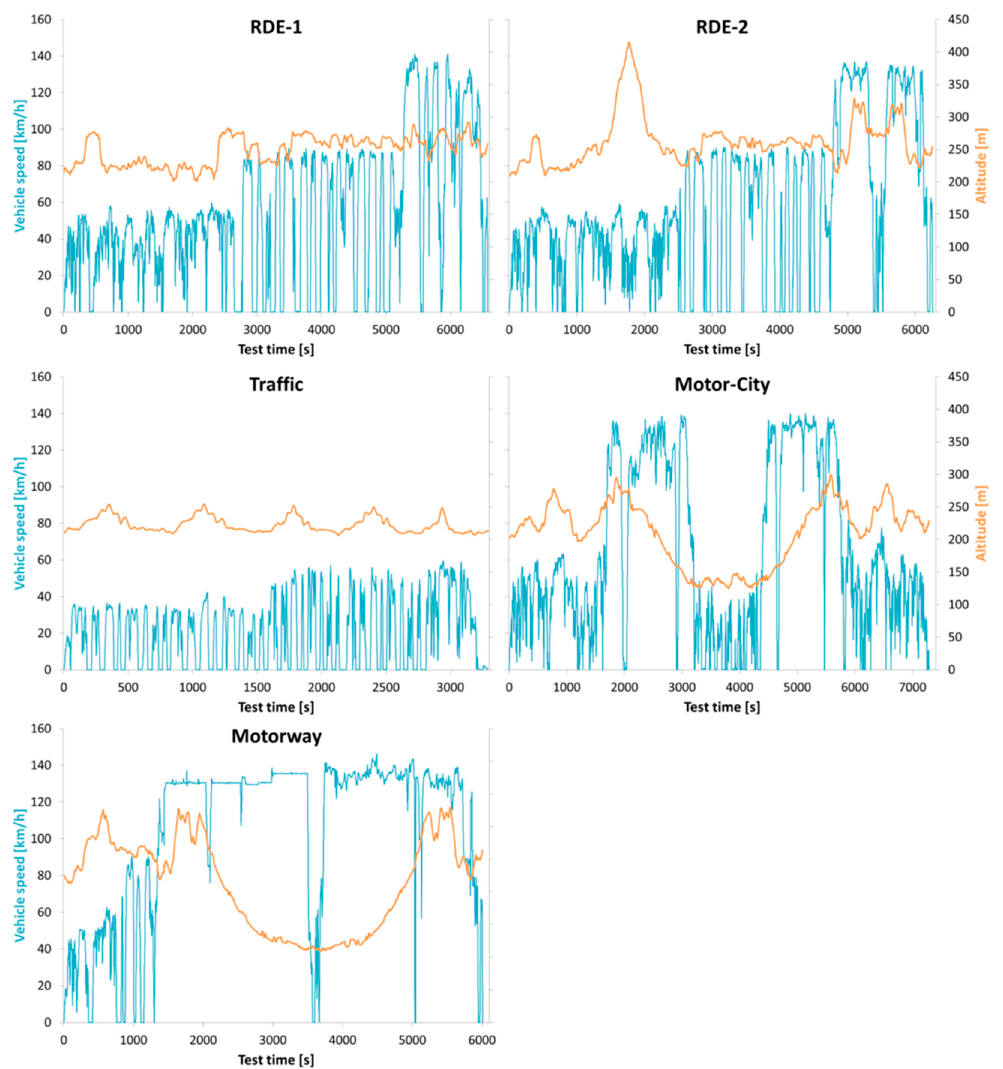
Figure A1. Vehicle speed [km / h] and altitude [m] profiles as measured with the GPS (Global Positioning System) of the PEMS (Portable Emissions Measurement System) of the routes used in the test campaign.